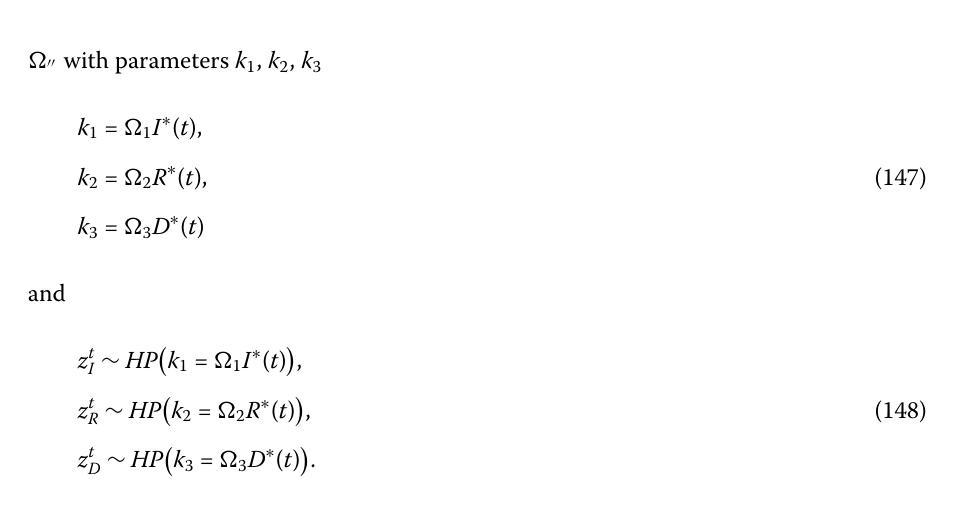
Figure 37 Numerical visualization of COVID-19 model for α = 0.95, β =